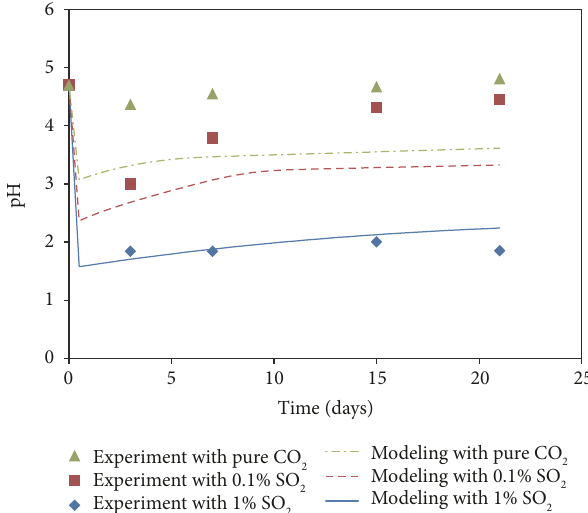
Figure 2: Changes in pH measured during gas-water-rock experi- ments (green triangle = pure CO 2 case, red square = 0.1% SO 2 case, andbluerhombus=1%SO 2 case)andchangesinpHinthemodeling (green dashed line = pure CO 2 case, red dashed line = 0.1% SO 2 case, and blue solid line = 1% SO 2